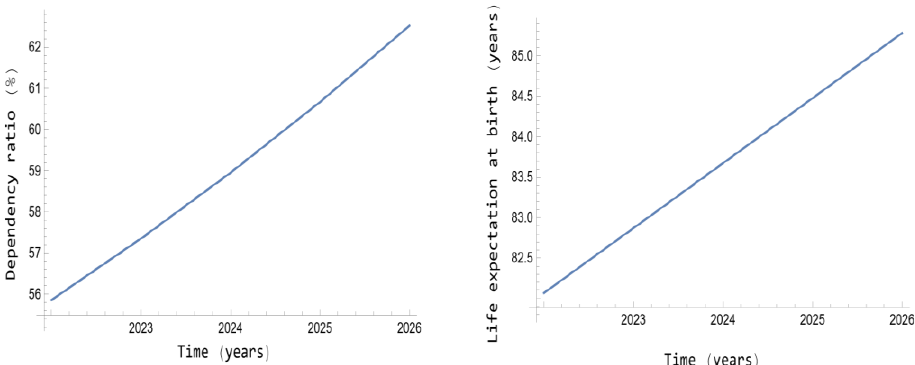
Figure 6. Dependency ratio ( left ) and life expectancy at birth ( right ) versus time forecasted in Spain for the 2022–2026 period.